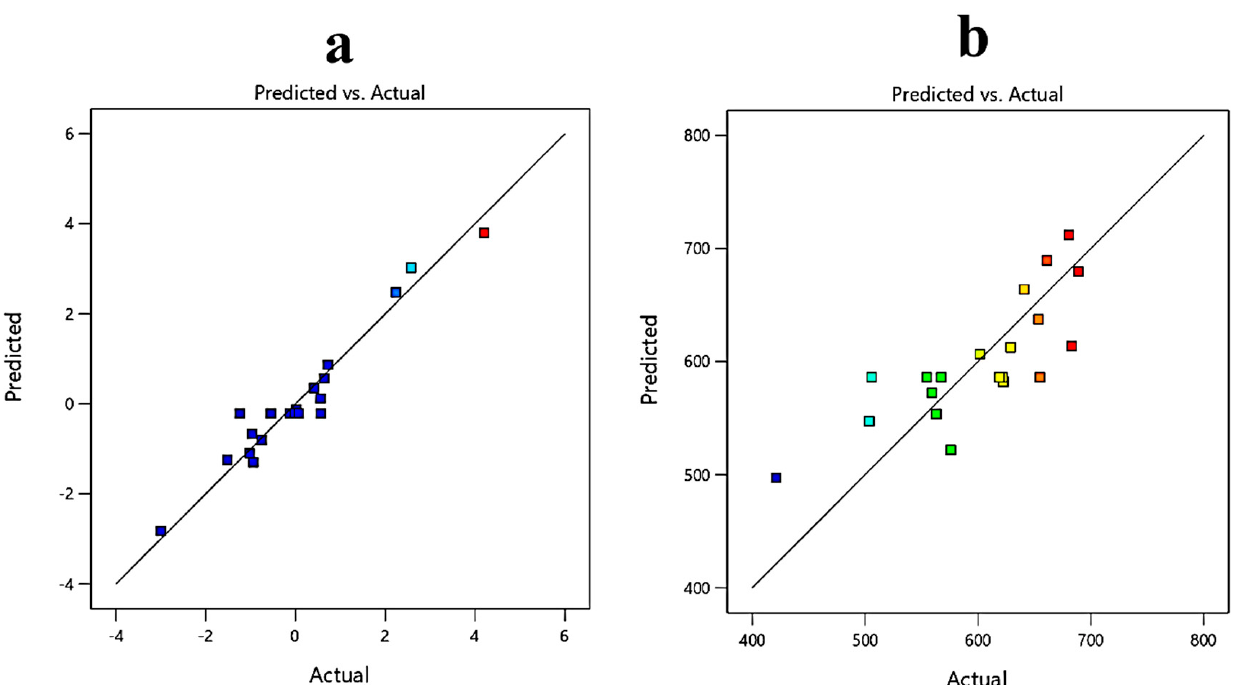
Figure 8. Predicted versus actual plot for ( a ) ricinoleic acid yield (g/kg); ( b ) oil loss (g/kg).